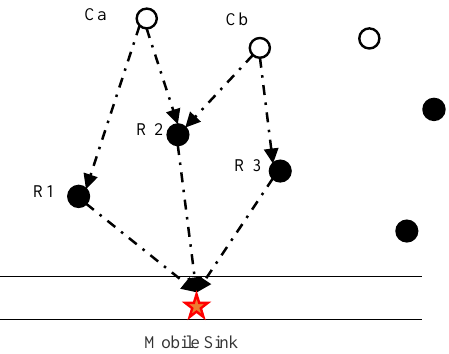
Figure 7. Schematic diagram of bearer selection